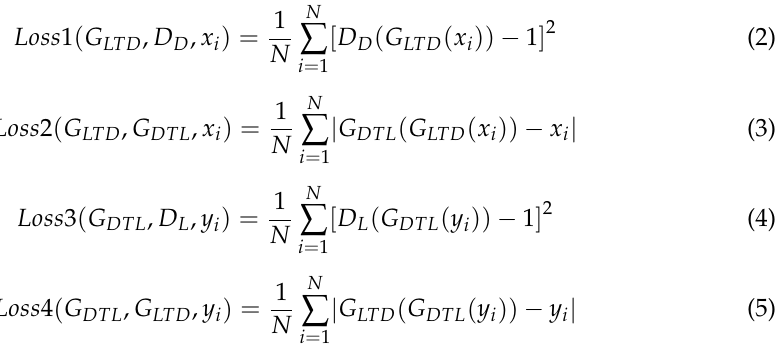
Figure 3. Generator ( a ) and discriminator ( b ) structures in the label-to-data networks. 2.3. Networks Parameters and Training details Both G LTD and G DTL have a U-Net structure (Figure 3a). The input is a single channel label image of size 128 × 128 pixels and the output is the generated seismic image (of the same size). The maximum number of channels in the networks is 256, and the data are down- and up-sampled three times each. Both D D and D L have a six-layer CNN structure (Figure 3b). The input is a real or generated image of size 128 × 128 pixels, and the output is the discrimination result. Assuming the image is true, this output should be 1; other- wise, it is 0. We prepared 1000 labels and seismic samples for training, and set the training epoch to 200, batch size to 10, a learning rate of G to 5 × 10 −5 , and a learning rate of D to 1 × 10 −4 . The optimization algorithm was Adam [34]. In addition, the weights of Loss1 – Loss4 can be adjusted according to the real situation. For example, when G LTD cannot transform